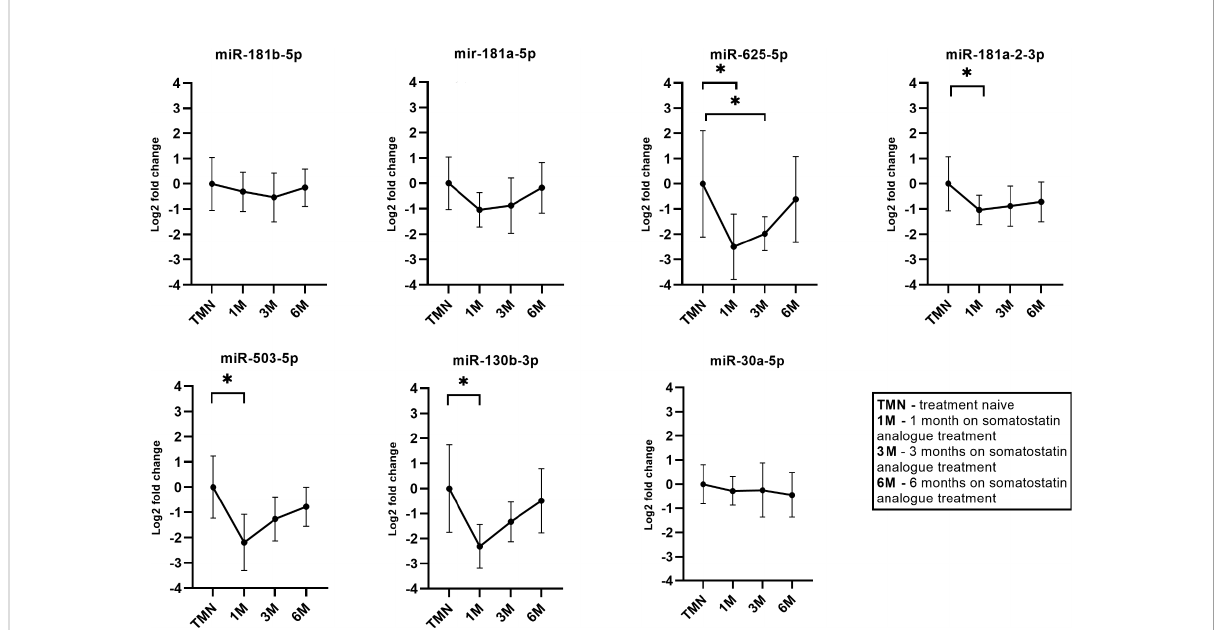
FIGURE 6 Expression by qPCR of seven candidate miRNAs before and during the somatostatin analogue (SSA) treatment. 1M – one month during SSA treatment, 3M – three months during SSA treatment, 6M - six months during SSA treatment. With “ * ” are marked changes with P < 0.05. P values were calculated using multiple linear regression by including the following factors: age, sex, body mass index, treatment